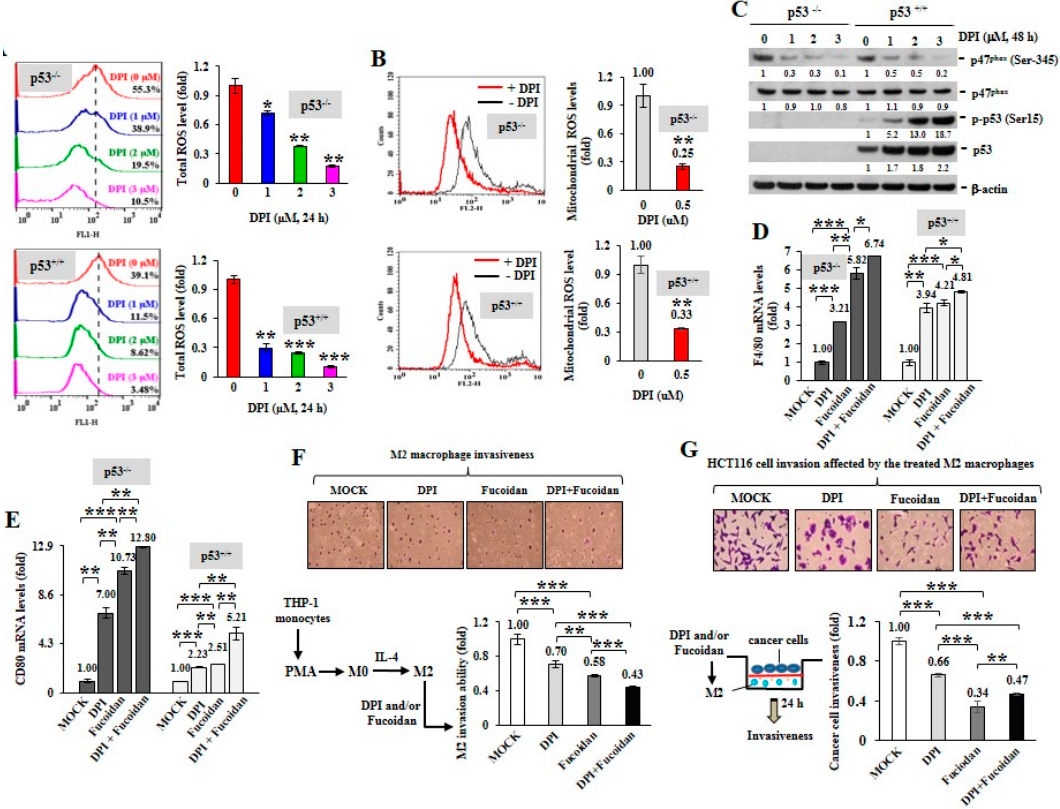
Figure 2. ROS inhibition in cancer cells induces M1 macrophage phenotypes. Total cellular ROS